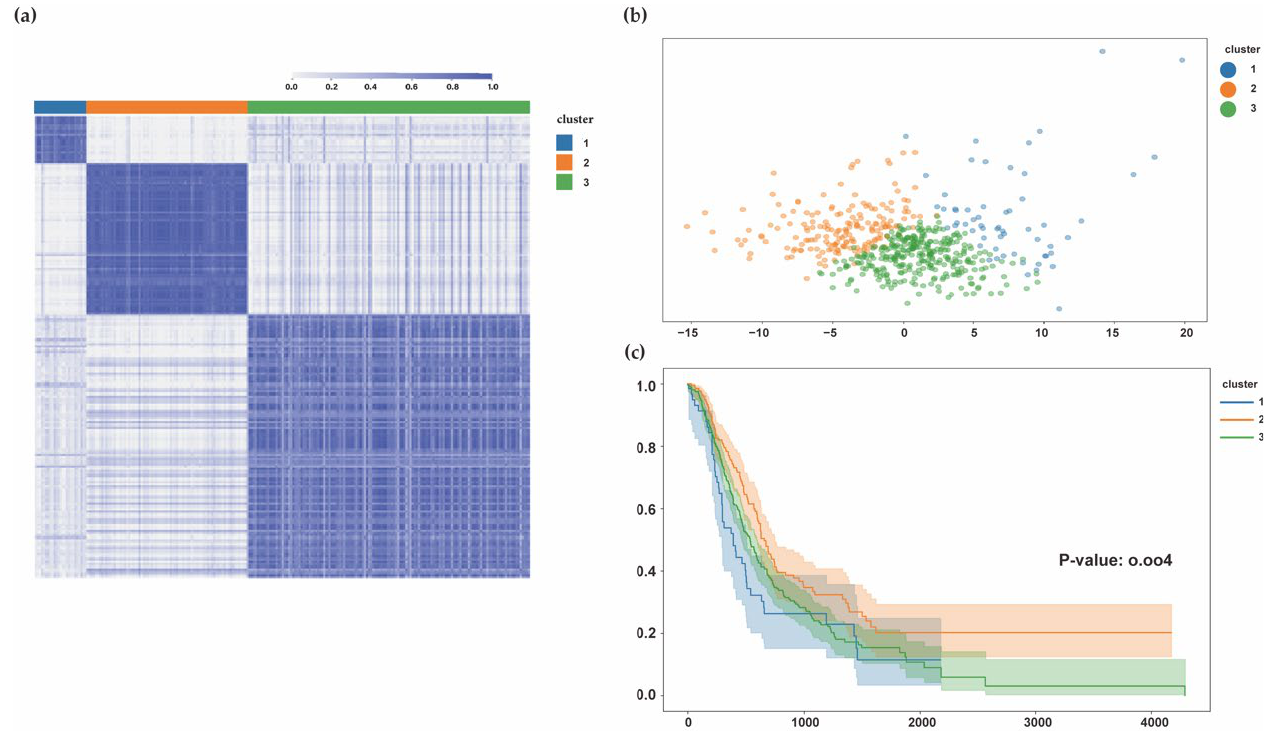
Figure 4. Metabolic subtypes rely on HIF-1 and sphingolipid pathways (cluster1 = 59, cluster2 = 183, cluster3 = 321). ( a ) Clustering heatmap (k = 3) of metabolism pathways in 563 samples. ( b ) PCA (Principal Component Analysis) plot of three cluster groups under NMF method. ( c ) Kaplan–Meier survival analysis of patients in multiple metabolic subgroups. (TCGA: